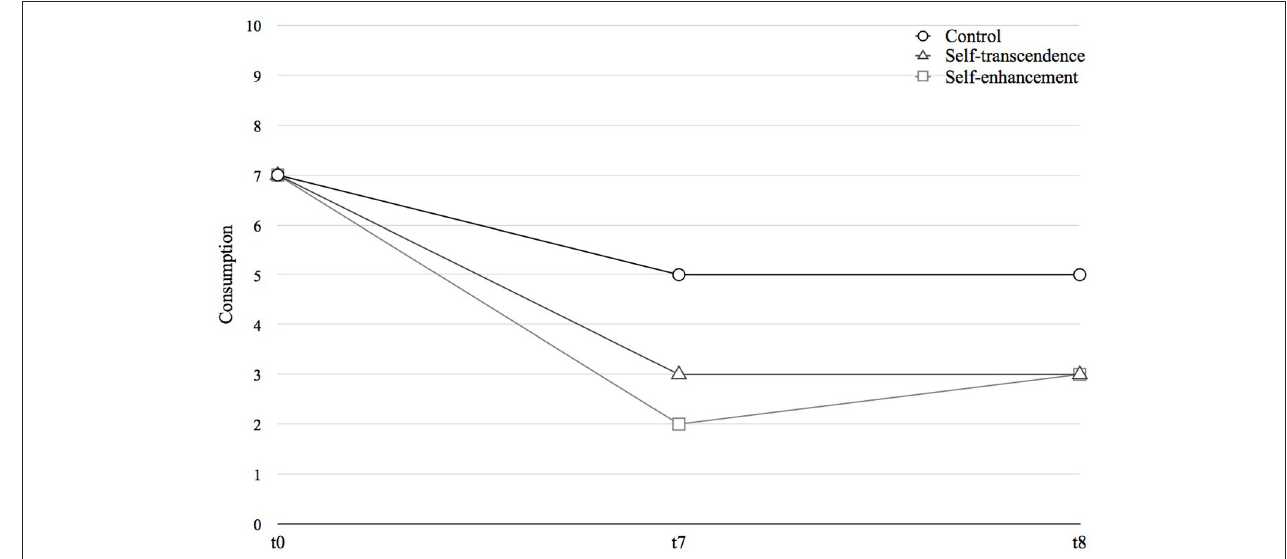
FIGURE 2 | Proposed pattern of results showing reduced consumption within experimental